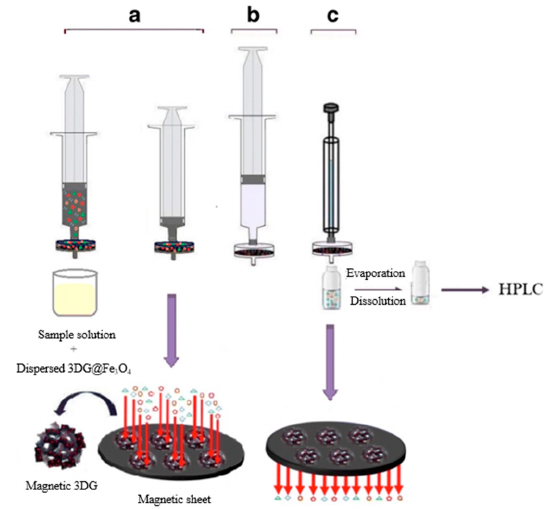
Figure 1. After conditioning the nanomaterial using methanol (MeOH) and water, 50 mL of an aqueous-organic extract, obtained after ultrasound assisted-solid-liquid extraction of 3 g of dried bread matrix, were loaded in a syringe and passed through the material magnet filter. By pulling back the plunger, the adsorbent particles were removed from the magnetic sheet and dispersed into the syringe. Then, the plunger was pushed to pass the sample solution through the filter and the analytes were eluted using 700 µL of MeOH and subsequently analysed by HPLC-fluorescence detection (FD). Validation of the methodology led to intermediate recovery values (59–69%) and good sensitivity with LODs in the range 0.06–0.1 µg/kg.